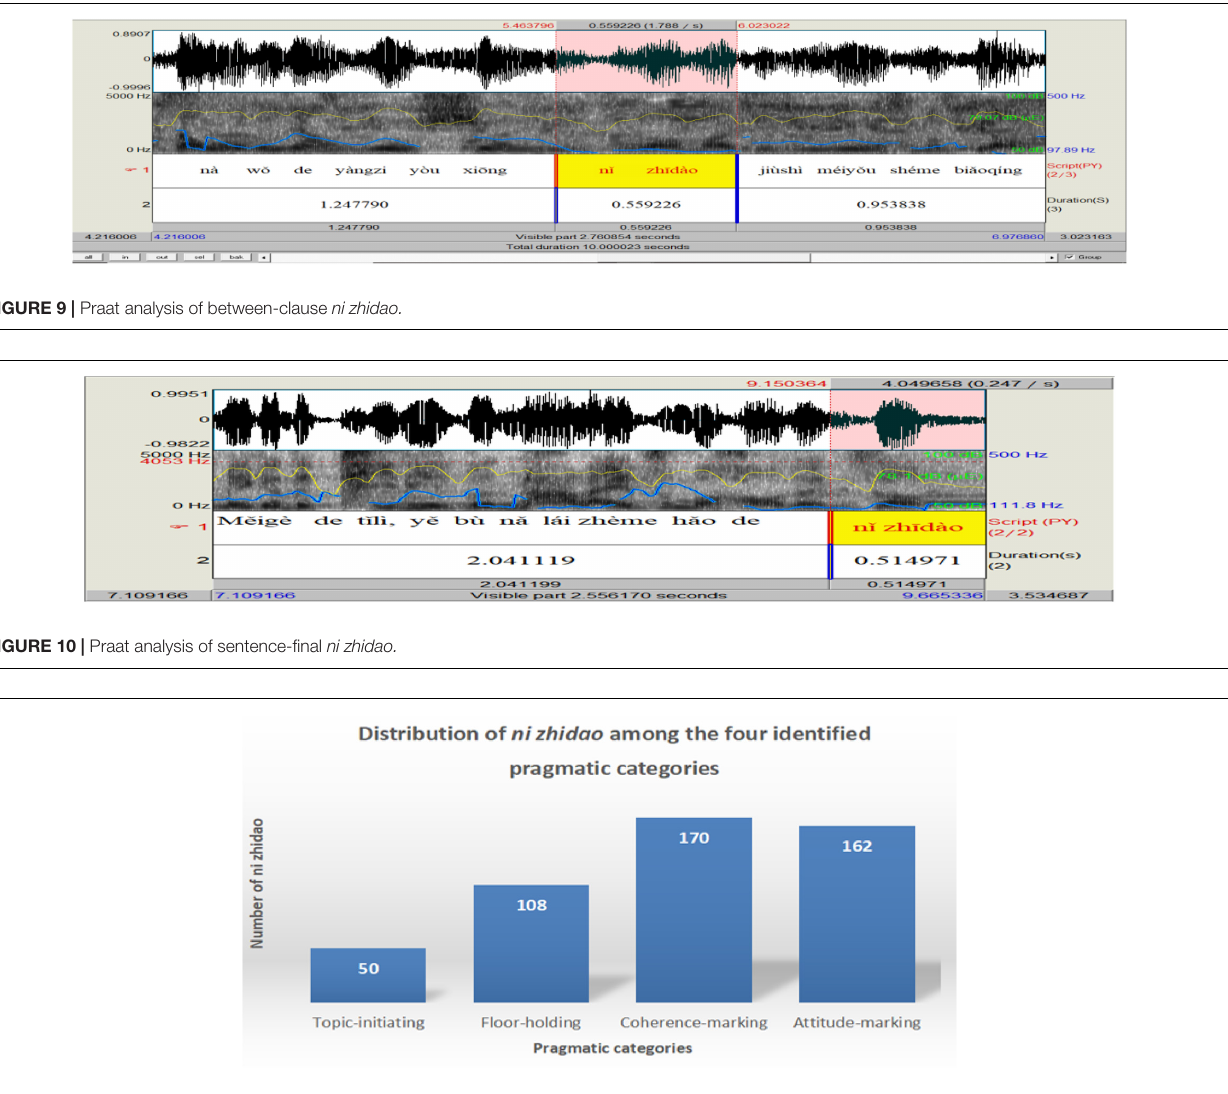
FIGURE 11 | Distribution of ni zhidao among the four identified pragmatic